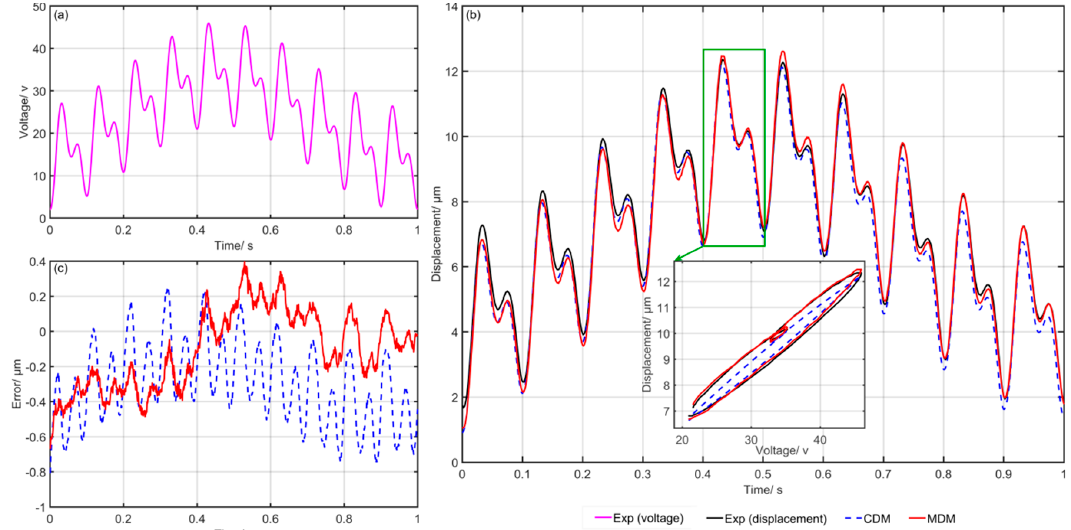
Figure 6. Exp1: Comparison of the experimental and simulation results of the CDM and MDM under u 1 ( t ) = 10sin ( 2 π · t ) + 8sin ( 2 π · 10 t ) + 6sin ( 2 π · 20 t ) + 24: ( a ) Time histories of input voltage, ( b ) time histories of output displacements and ( c ) time histories of errors of the CDM and MDM.